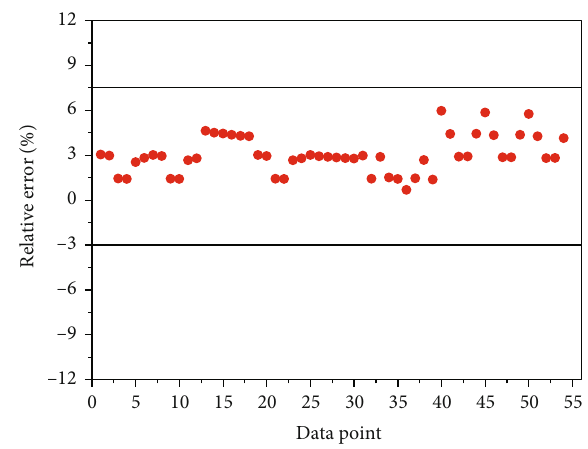
Figure 8: Error of the prediction model and experimental data.